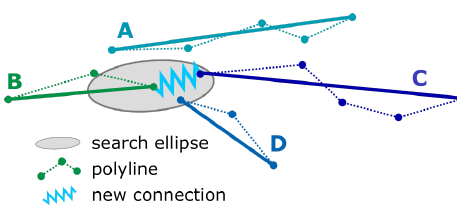
Figure 5. Example for demonstrating the problem of connecting adjacent LKFs. Dotted lines indicate single segments of the real LKF, the solid lines represent the major orientation of the LKF. In the search ellipse, the end point of line B can potentially be connected to line C or D . The decision is based on differences between the major